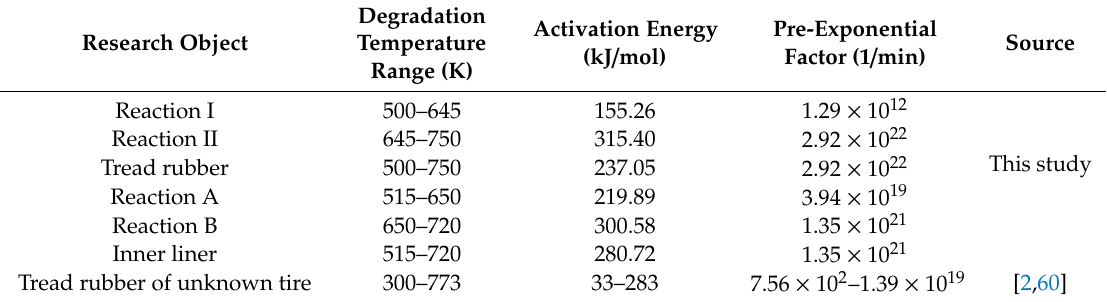
Table 6. Comparison of the conclusions obtained from this study with other published results. Research